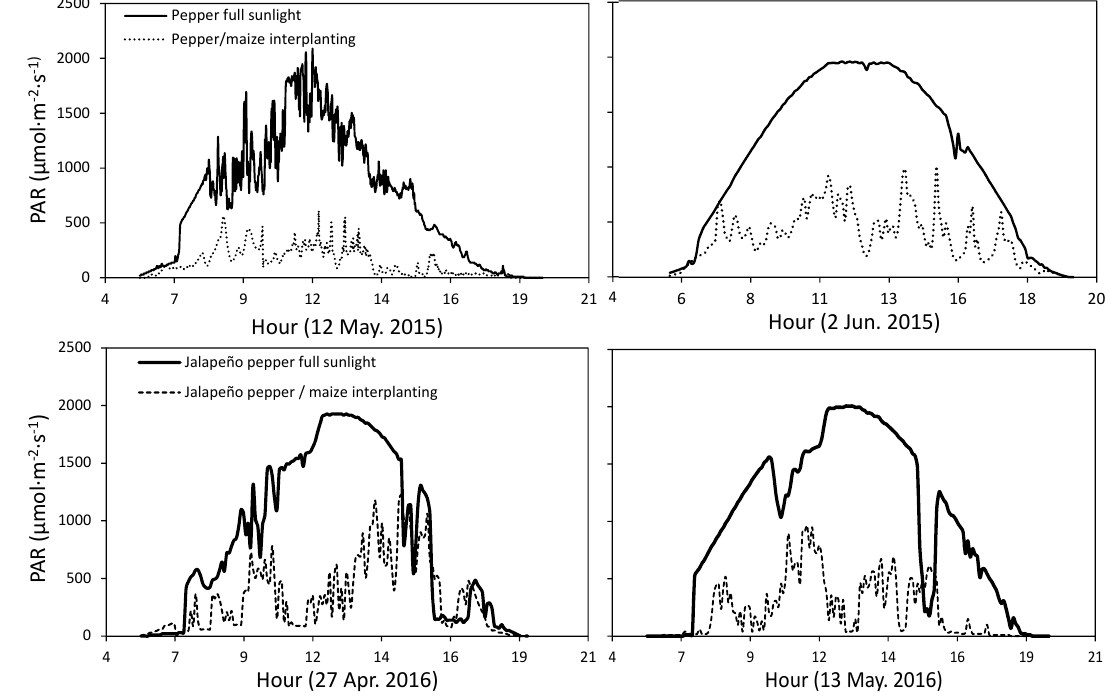
Figure 1. Photosynthetic active radiation (PAR) distribution of a jalapeño pepper canopy as affected by intercropping, during 2015 and 2016.